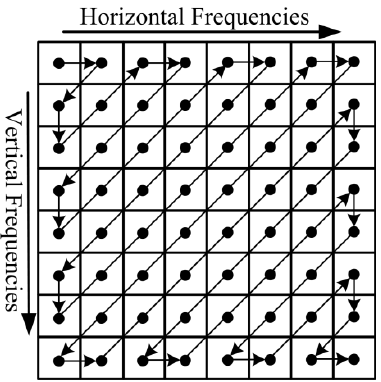
Figure 2 . Sequence of an 8×8 frequency